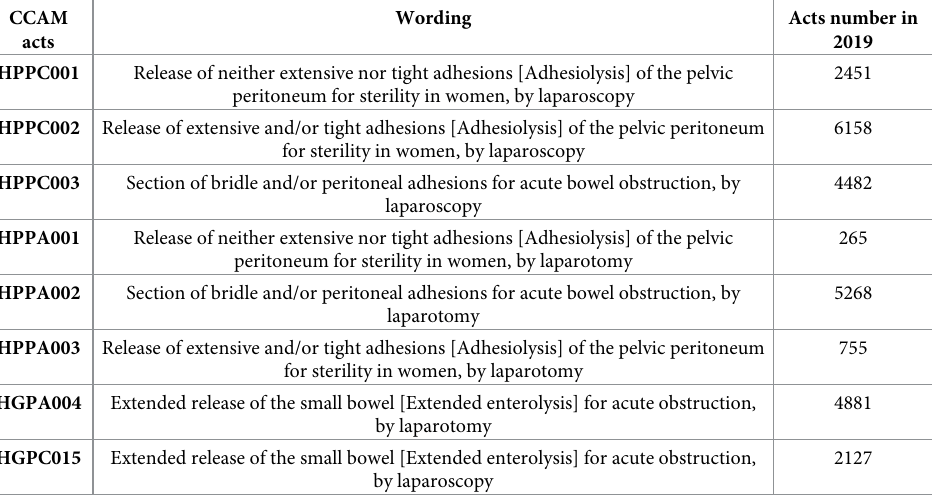
Table 1. Descriptive of different CCAM adhesiolysis acts in the PMSI in